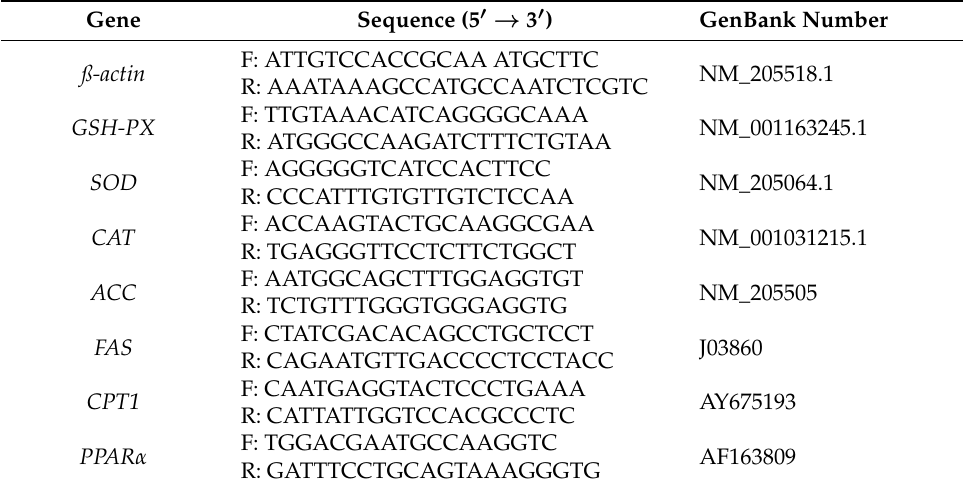
Table 2. Primer sequences used for qRT-PCR